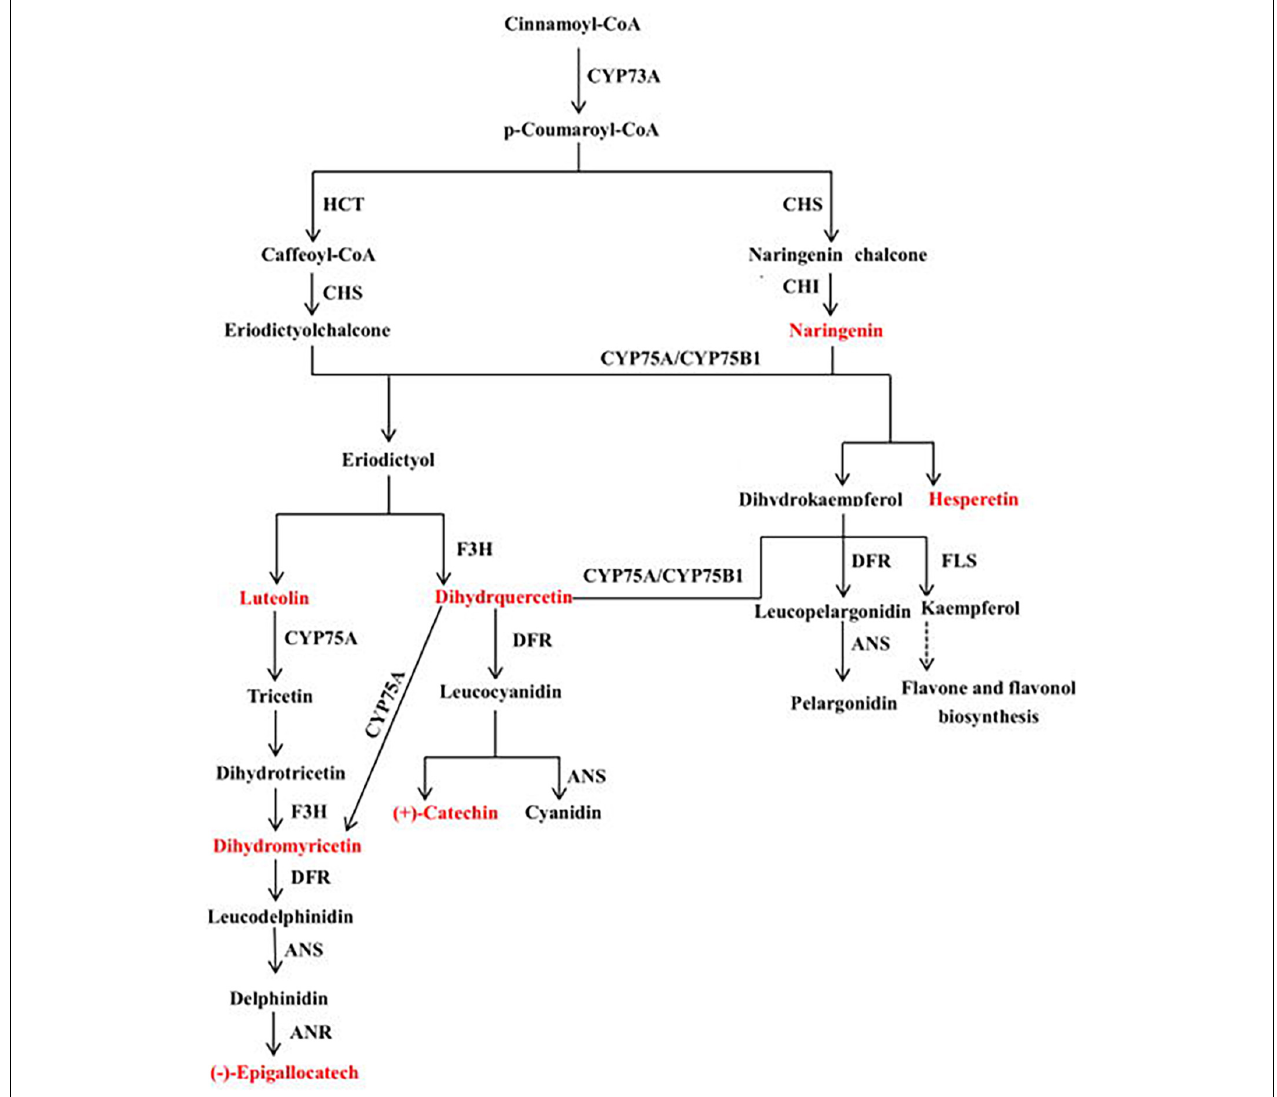
FIGURE 8 | Mechanisms underlying flavonoid biosynthesis in wheat varieties with different grain colors. This pathway was constructed based on KEGG pathway and literature sources.